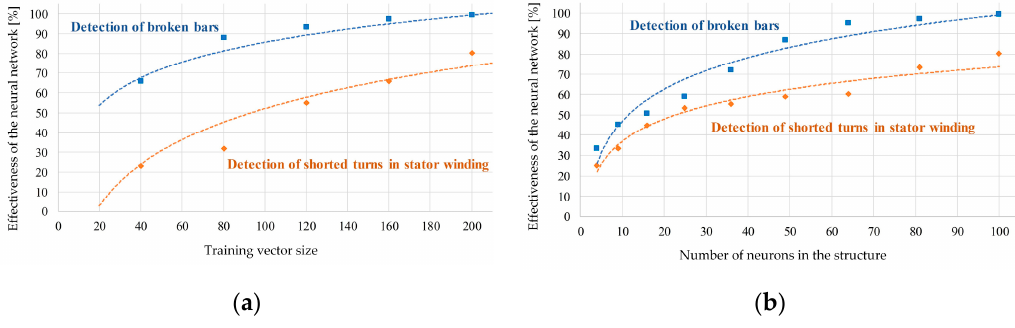
Figure 14. Analysis of the e ff ectiveness of the RHN based fault detector: ( a ) the influence of the base vector size; ( b ) the influence of the number of neurons.